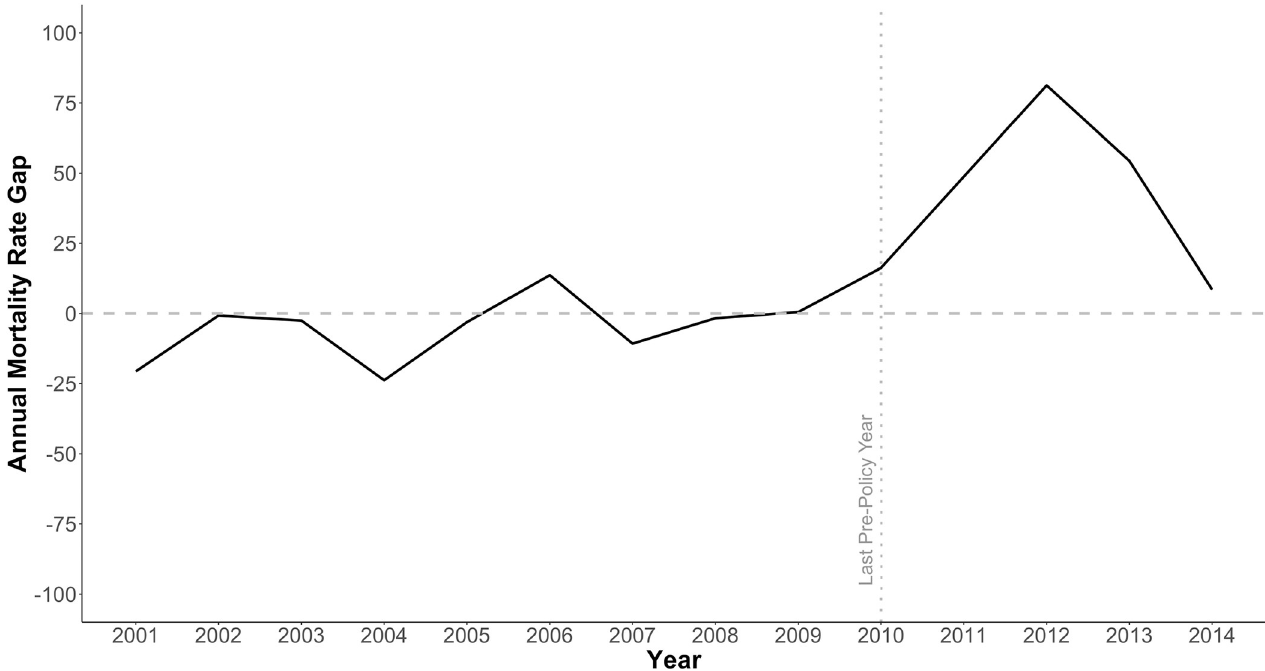
Fig 2. Annual prisoner mortality rate gap between California and synthetic control, 2001–2014.